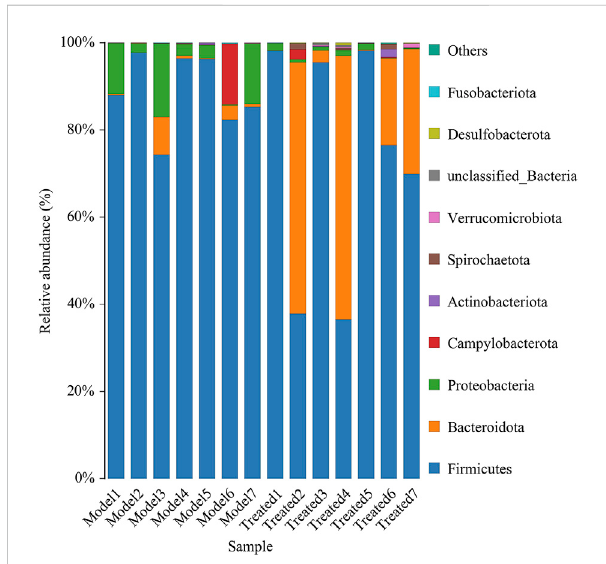
FIGURE 10 Average relative abundance of small intestinal microbial species at the phylum level. Model represents piglets challenged with PEDV, and treated represents piglets received an oral administration of HJ before PEDV challenged, n =